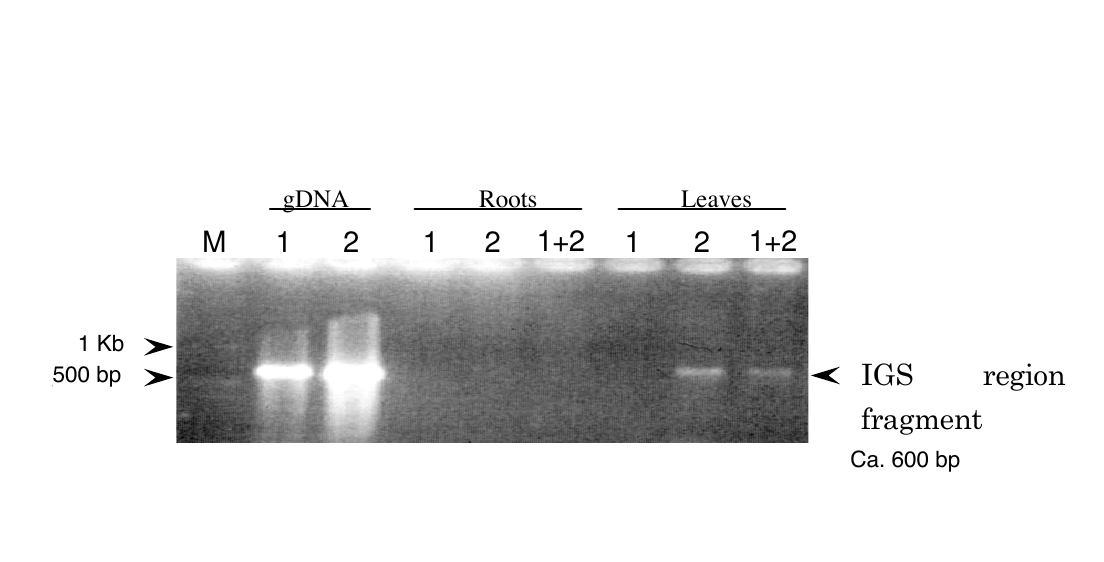
Fig. 4. PCR products with the IGS region primers using as templates DNA extracted from the roots and leaves of to- mato cv. Ponderosa 16 days after inoculation. Lanes: M, 100-bp DNA marker; gDNA, fungal genomic DNA extracted from Fusarium oxysporum f. sp. lycopersici race 1, and race 2 was used as a template; leaves, total DNA extracted from tomato cv. Ponderosa leaves inoculated with water (C), singly with race 1, and with race 2, and jointly with races 1+2, was used as a template; roots, total DNA extracted from tomato cv. Ponderosa roots inoculated singly with race 1, and with race 2, and jointly with races 1+2 was used as a